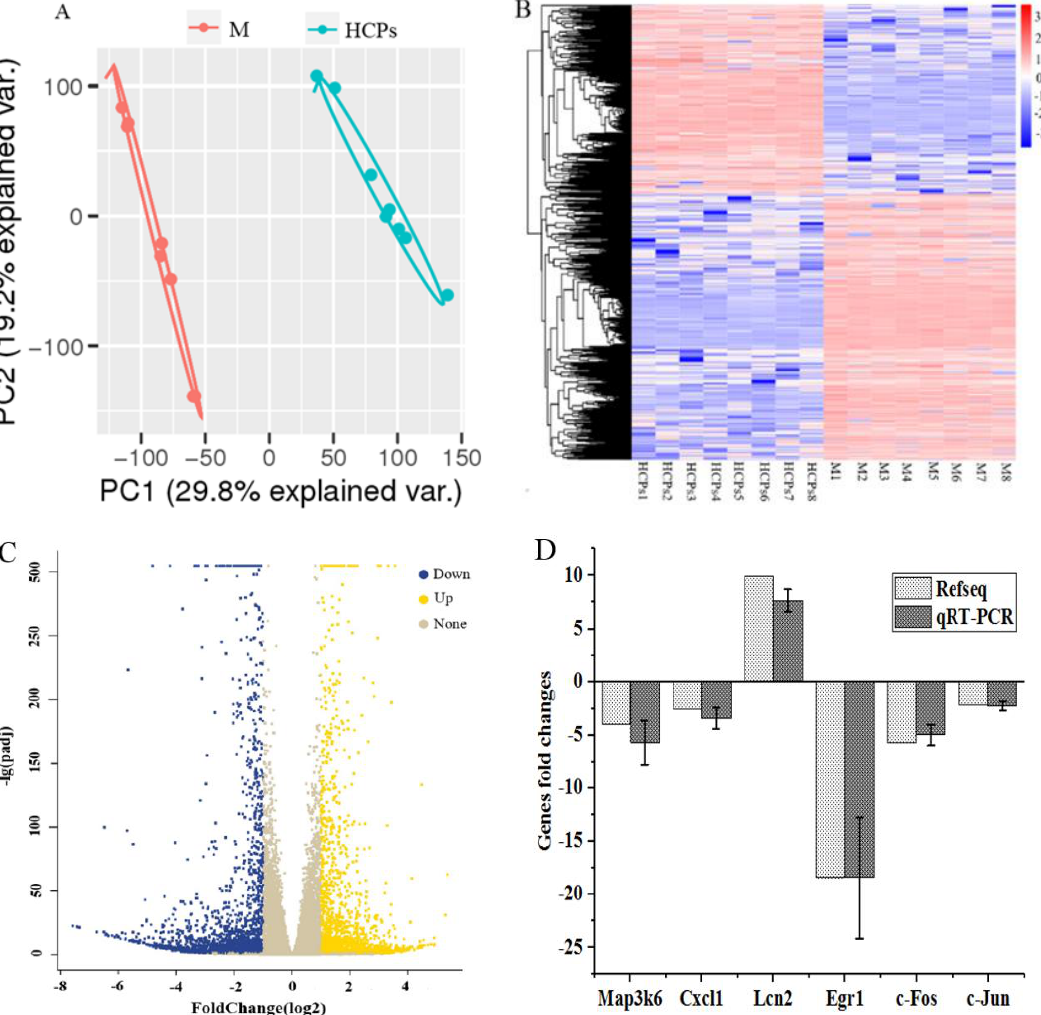
Figure 4. Differentially Expressed Genes (DEGs). ( A ) Volcano plot of DEGs; ( B ) Hierarchical cluster analysis of DEGs; ( C ) Volcano plot of DEGs; ( D ) Validation of the selected genes by qRT-PCR.